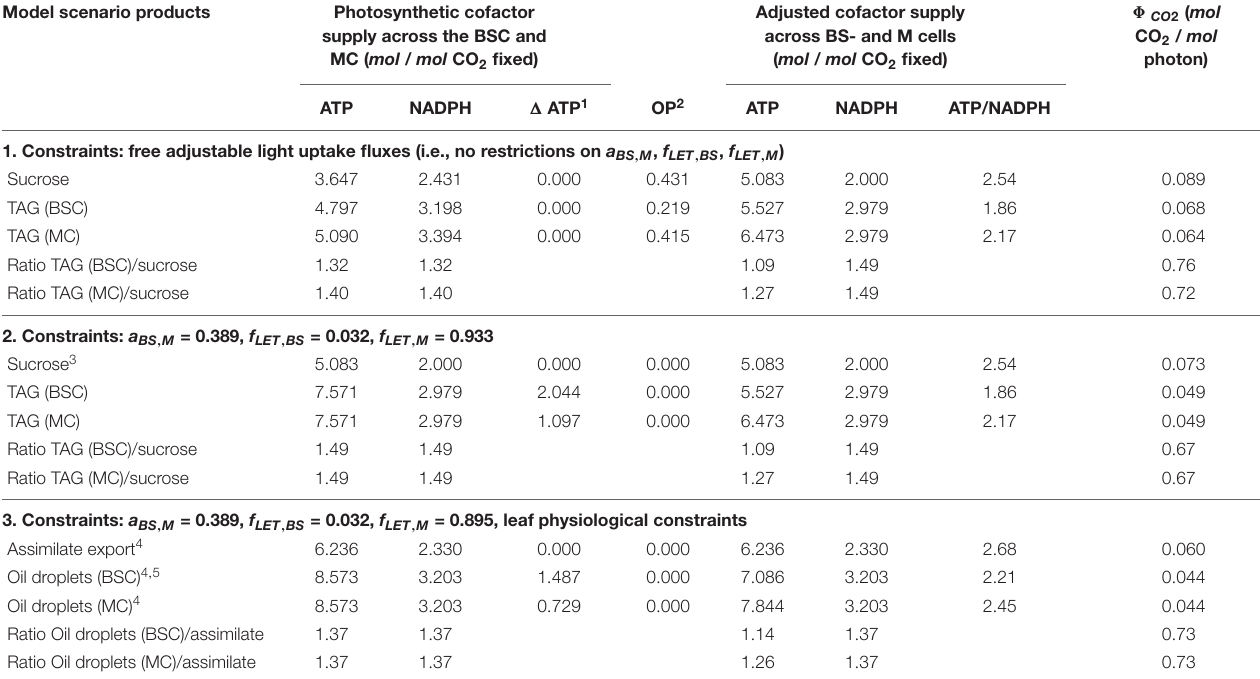
Table 7 . Shown are supply of ATP and NADPH, directly from photosynthetic light reactions and after adjustments that account for ATP surplus ( (cid:49) ATP) and the activity of oxidative phosphorylation (OP) in mitochondria (see Supplementary File 3 ). The adjusted energy budget equals the cellular metabolic demands plus cellular maintenance costs. For scenarios 1 and 2, leaf physiological constraints, including cellular maintenance, CO 2 leakage and photorespiration ( Supplementary Table 2 ), were omitted to obtain the energy cofactor balances solely based on photo assimilation of CO 2 into sucrose or TAG. 1 ATP surplus encompassed in the photosynthetic ATP value (see Figure 2B and section “Materials and Methods”). 2 Amount of reducing equivalents (mol / mol CO 2 fixed) primarily produced by photosynthesis that was consumed in mitochondrial oxidative phosphorylation to adjust supplies (1 NADPH yields 3.33 ATP). 3 Scenario of Figure 3